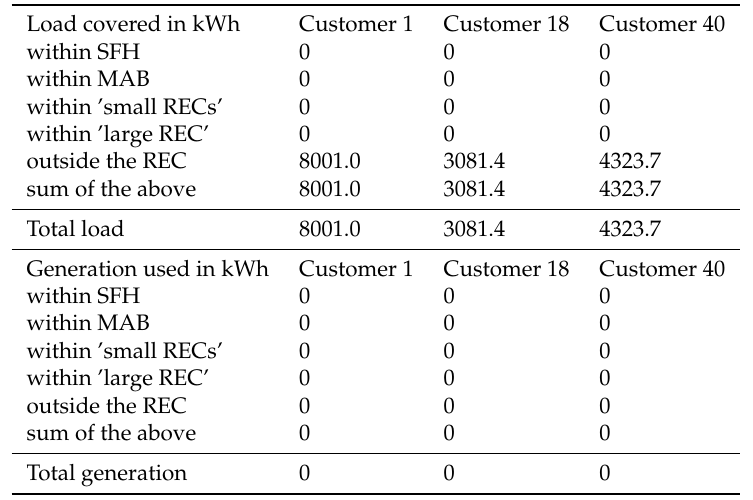
Table 4. Validation of the simulation model. Results provided for the theoretical case study of a purely residential REC. No PV systems available; thus, no electricity transfer within the